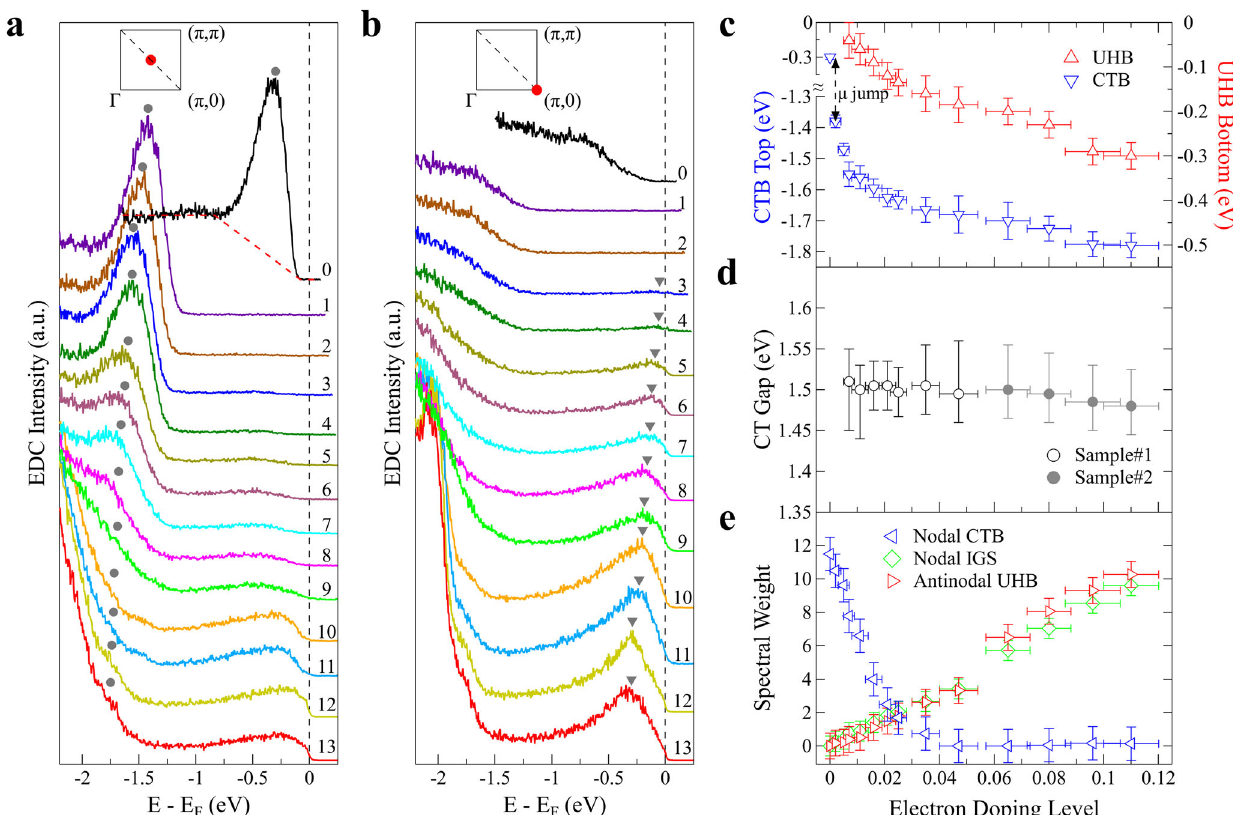
Fig. 3 Doping evolution of the charge-transfer band (CTB), upper Hubbard band (UHB), and the low-energy in-gap states (IGS). a Doping evolution of EDCs taken at ( π /2, π /2) point. The peak position of the EDCs, marked by gray circles, de fi nes the top of the nodal charge-transfer band. b Doping evolution of EDCs taken at ( π , 0) point. The peak position of the EDCs, marked by gray triangles, represents the bottom of the antinodal upper Hubbard band. c The EDC peak positions of the nodal charge-transfer band and antinodal upper Hubbard band extracted from ( a ) and ( b ), respectively. d The magnitude of the charge-transfer gap (CT Gap) determined from the difference of the nodal CTB and antinodal UHB positions in ( c ). e Doping evolution of the spectral weight of the nodal CTB (blue triangles), antinodal UHB (red triangles), and nodal in-gap states (IGS) (green diamonds). The nodal CTB spectral weight is obtained from the EDC peak area in ( a ) after subtracting the linear background as illustrated by the red dashed line in ( a ) for the EDC of the undoped sample. The spectral weight of antinodal UHB and nodal IGS is obtained by integrating the EDCs in ( b ) and ( a ) over an energy window [ − 1, 0.03] eV,